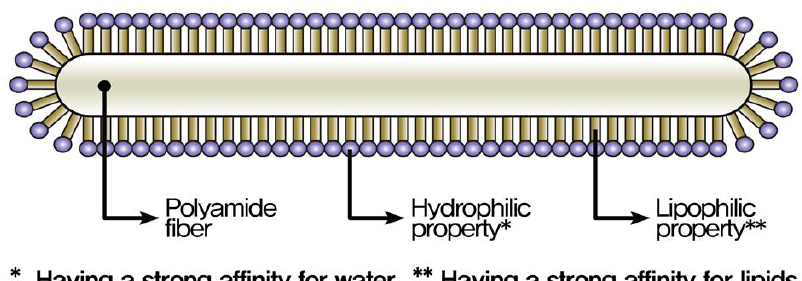
Figure 2. PA fiber (Diameter: 23 μm) with dispersant